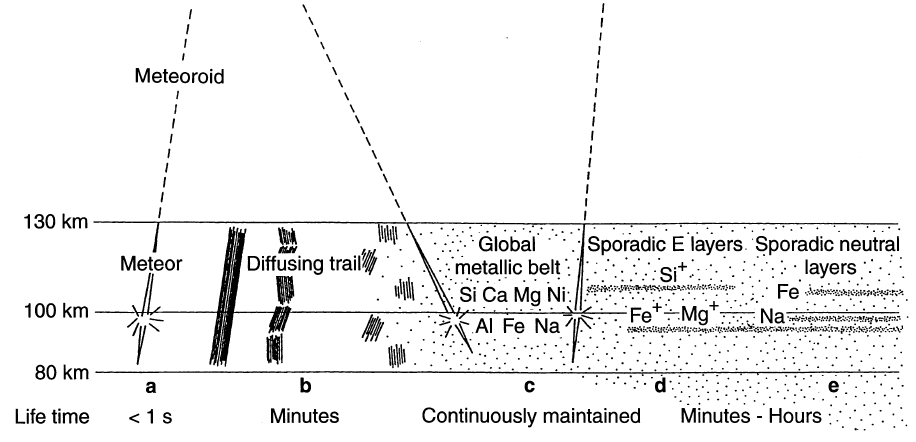
Fig. 1. Illustrating the process of meteoroid deposition in the atmo- sphere. The visible meteor is instan- taneous ( a ), while its trail can be observed for minutes ( b ). The global metallic belt is continuously main- tained by deposition of meteoric matter ( c ), while the old constituents slowly drift downwards and are lost. Ionised sporadic E layers are formed occasionally ( d ) and sporadic neutral layers can form simultaneously ( e